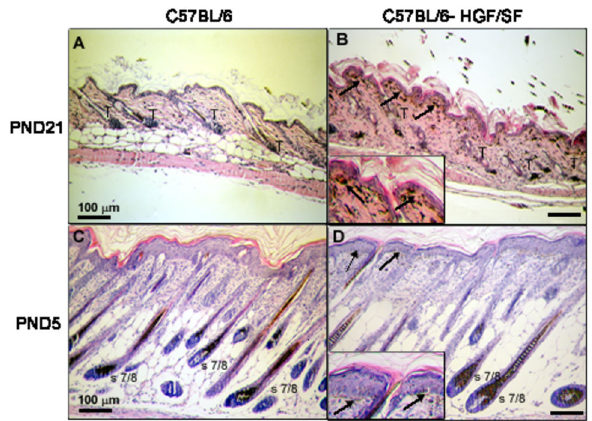
Figure 1. Haematoxylin and eosin staining of mouse skin of different age and hair cycle. (A,C) C57BL/6. (B,D) C57BL/6-HGF/SF. (A-B) PND21 (postnatal day 21). (C-D)- PND5 (postnatal day 5). Arrows – extrafollicular melanocytes; T- telogen hair follicle; s 7/8- stage 7/8 of hair follicle morphogenesis. Scale bar - 100 µm.